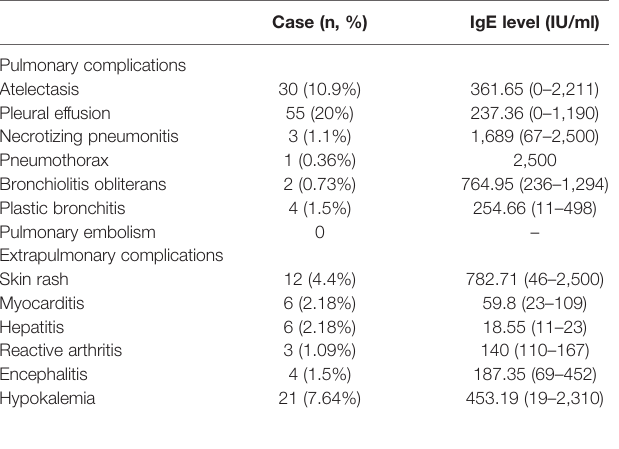
TABLE 2 | IgE levels of patients with different